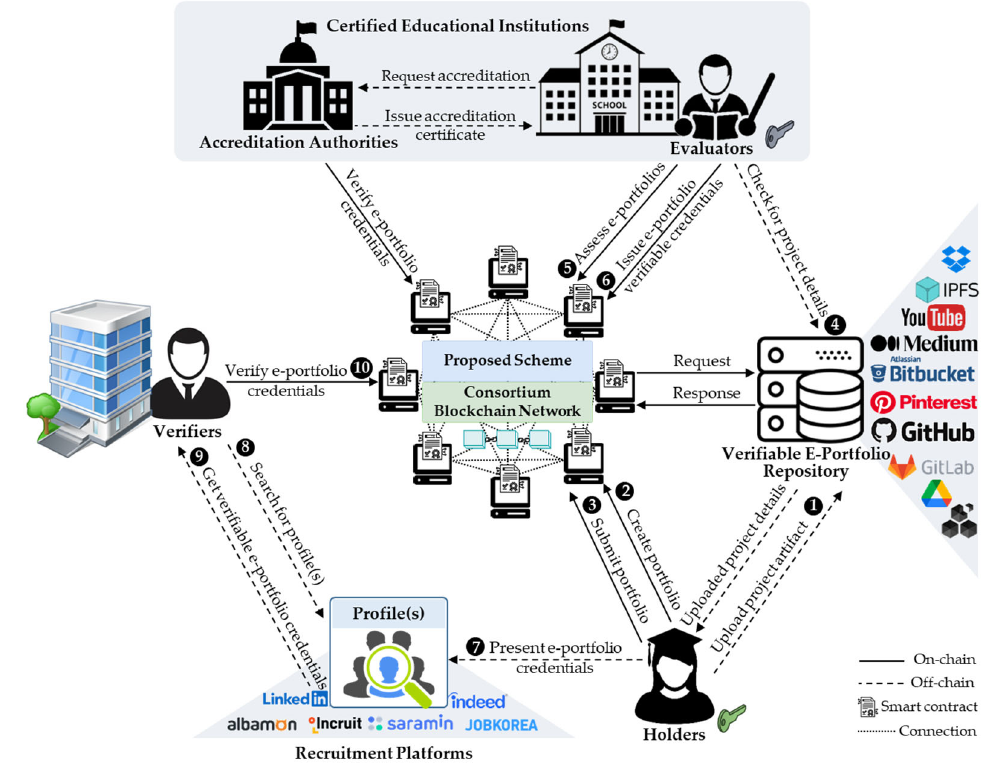
Figure 3. Overview of the proposed consortium blockchain-based secure and trusted e-portfolio management scheme.